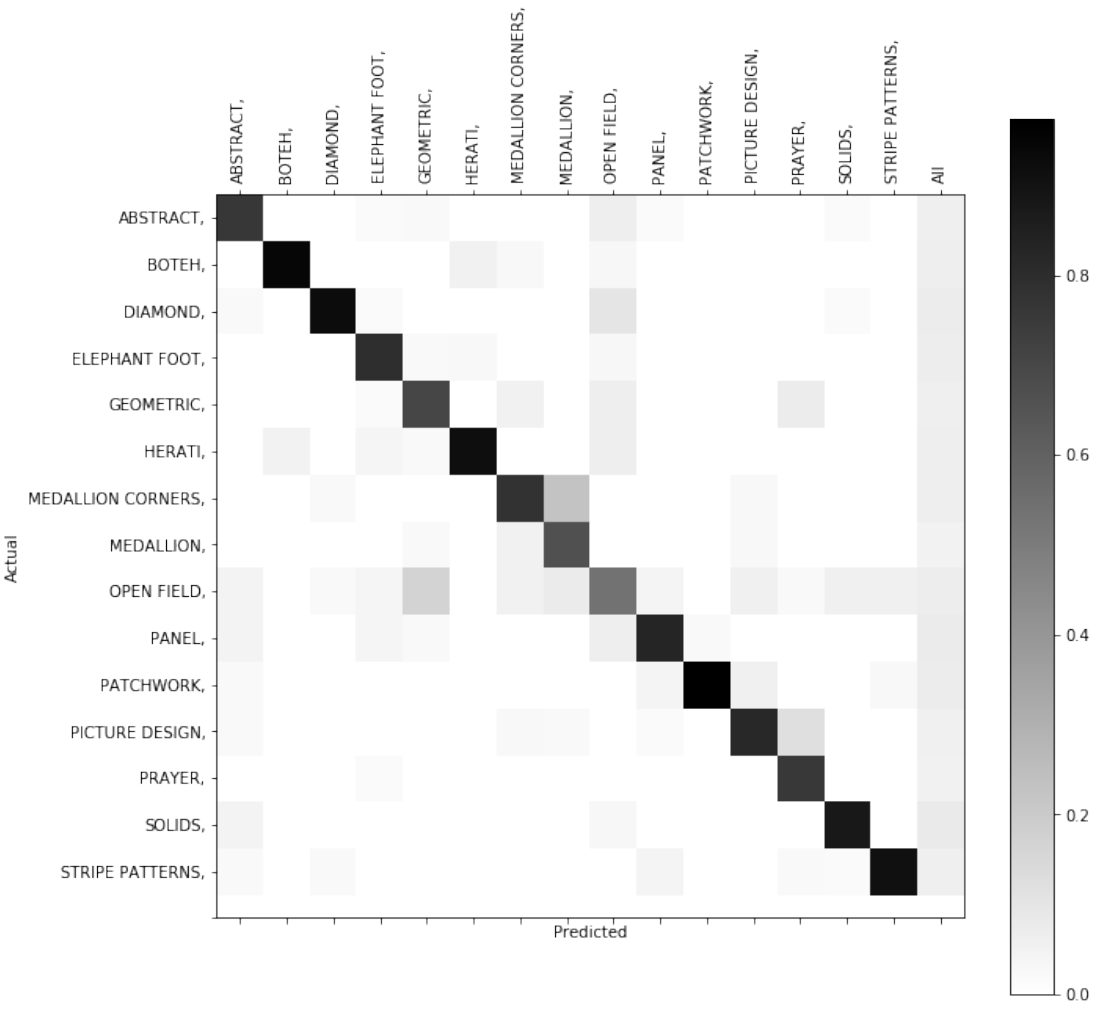
Figure 3. Pattern classification confusion